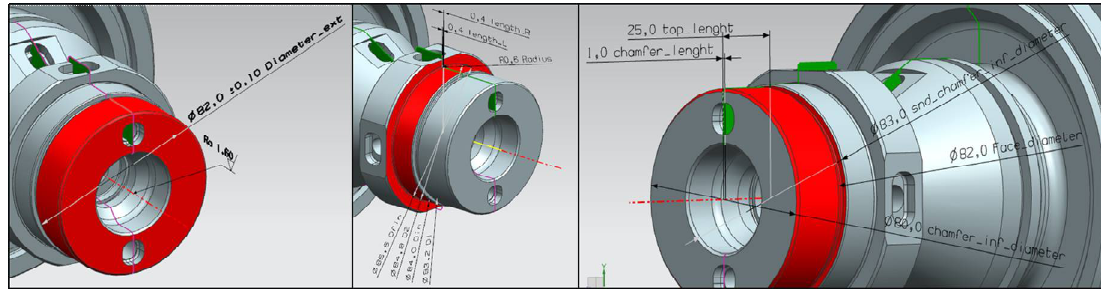
Figure 3. Feature examples.